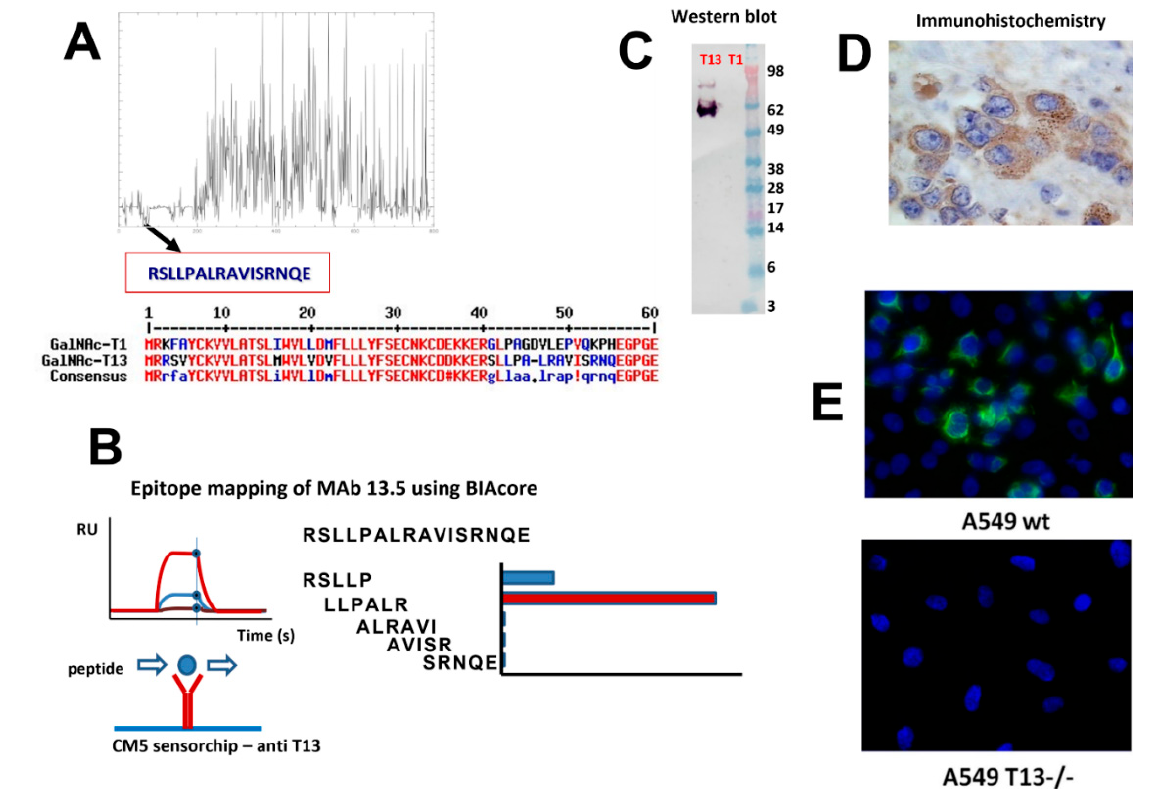
Figure 1. Anti-GalNAc-T13 monoclonal antibody production. ( A ) Selection of a differential sequence specific of GALNT13, avoiding cross reaction with GALNT1: Multiple sequence alignment calculated with MUSCLE v3.8.31 [32], plot performed using ‘plotcon’ from the EMBOSS suite [33], using a window size of 1. Selection of 16 aa sequence (residues 40–56) displaying no similarities with GalNAc-T1 was confirmed by MultAlin [34]. ( B ) Epitope mapping of MAb T13.5 by BIAcore using small synthetic peptides overlapping the whole sequence used for immunization. We deduced that the epitope matches with the LLPAL sequence. ( C ) Western blot performed with recombinant GalNAc-T13 and GalNAc-T1. ( D ) Confirmation of GalNAc-T13 expression by immunohistochemistry in formalin-fixed, paraffin embedded neuroblastoma tissues (magnification 400 × ). ( E ) Immunofluorescence of A549 wt and A549 T13-/- cell lines (magnification 200 ×